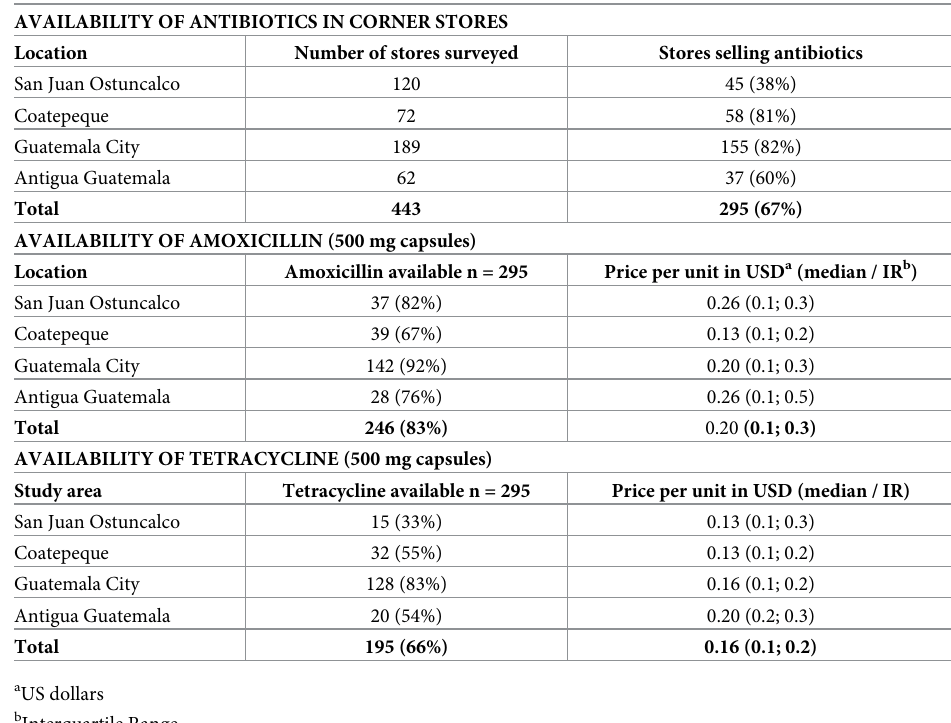
Table 2. Availability and prices of antibiotics in four municipalities of